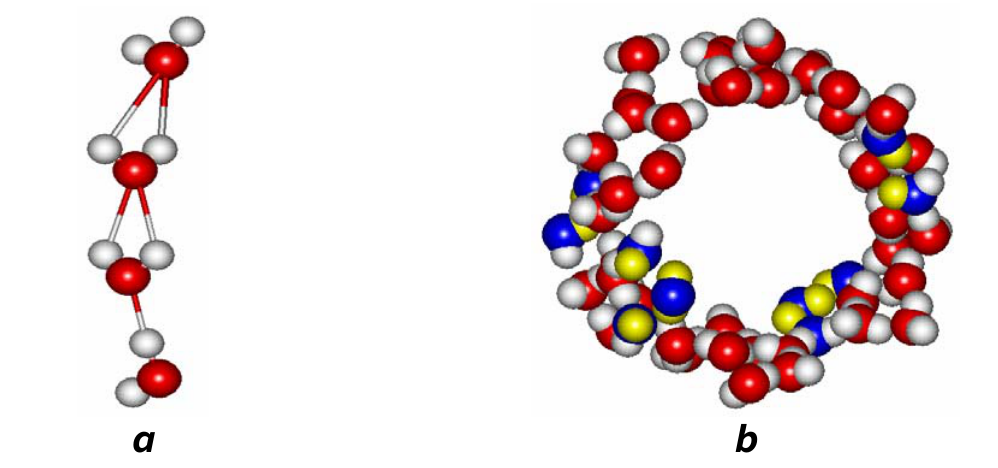
Figure 4. Similar to Fig. 3 observations concerning armchair CN tubes.